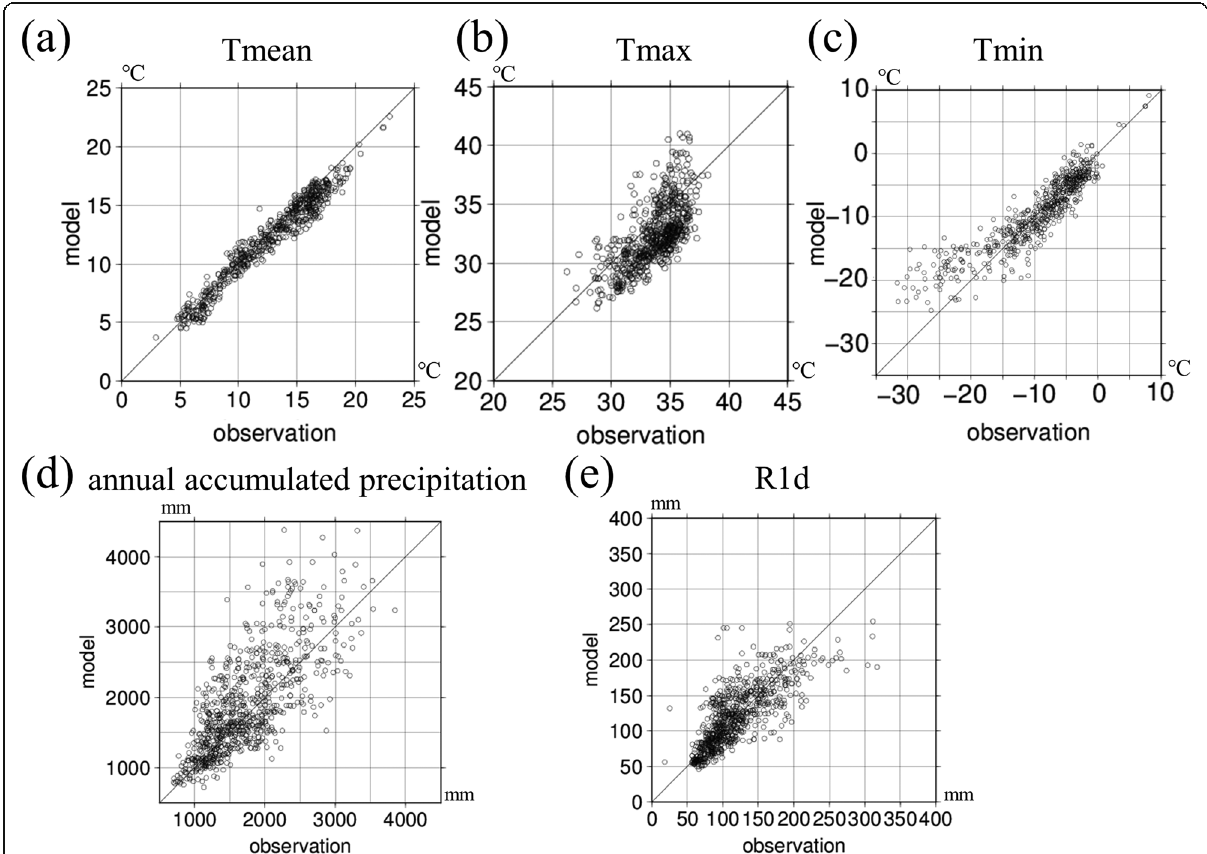
Fig. 3 Scatter plots of observed vs. model simulated daily temperature and precipitation. The x and y axes indicate the AMeDAS observations and the model simulations, respectively. In order to match the elevations between the model grid and the AMeDAS, the height correction of the surface air temperature is applied to simulated temperatures using a single lapse rate of 0.0065 Km − 1 ( a annual mean temperature, b Tmin, c